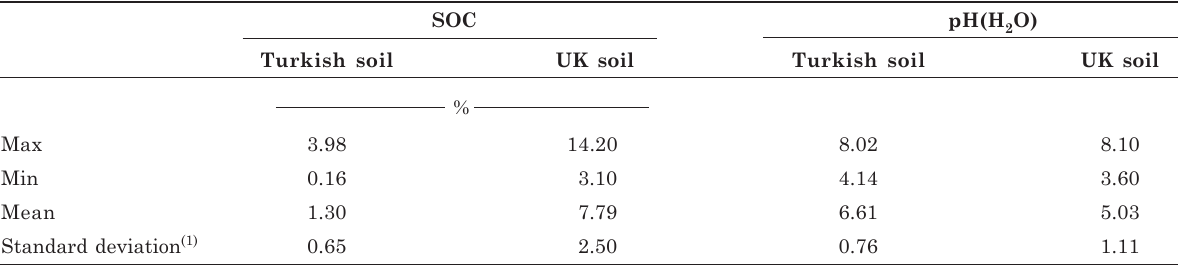
(1) Derived from Tekin et al.